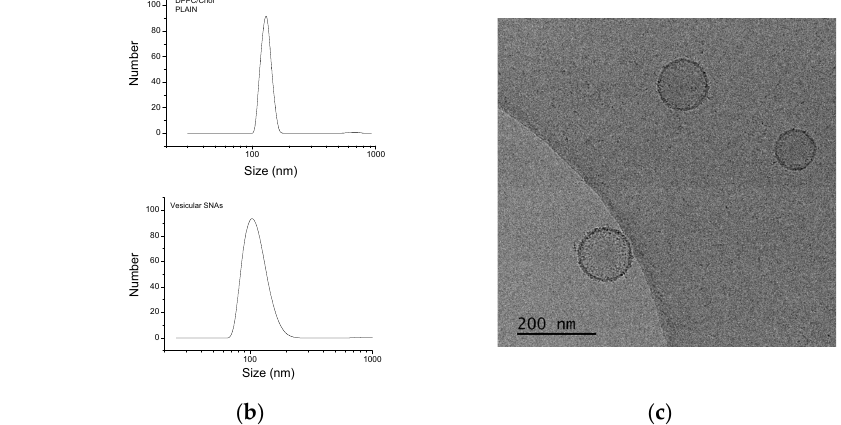
Figure 4. ( a ) UV-Vis spectra of vesicular SNAs and plain DPPC/Chol liposomes. ( b ) Size distributions from DLS of plain DPPC/Chol liposomes and vesicular SNAs as indicated. ( c ) Cryo-TEM images of vesicular SNAs. Table 1. Light scattering parameters and other characterization data of plain DPPC/Chol liposomes and vesicular SNAs, prepared by co-assembly of DPPC, cholesterol, and nucleolipid. Measurements were performed at 37 °C.